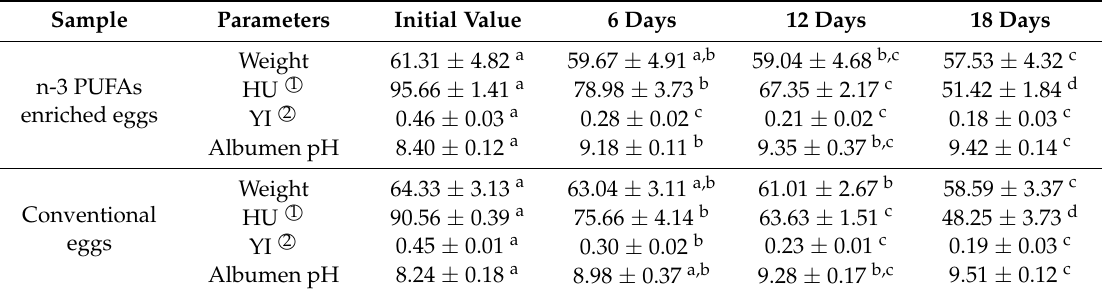
Table 2. The quality * changes of Omega-3 polyunsaturated fatty acids (n-3 PUFAs) enriched and conventional eggs under room temperature.